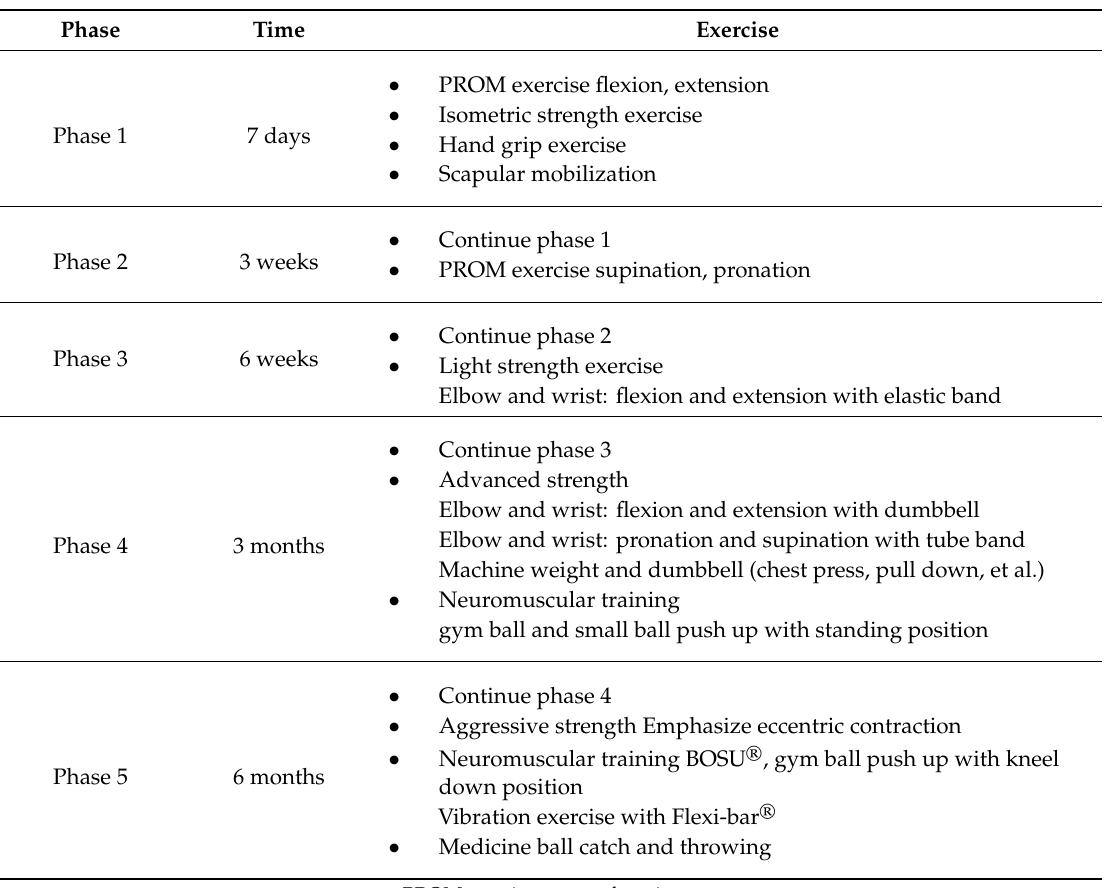
Table 2. Summary of rehabilitation exercise.